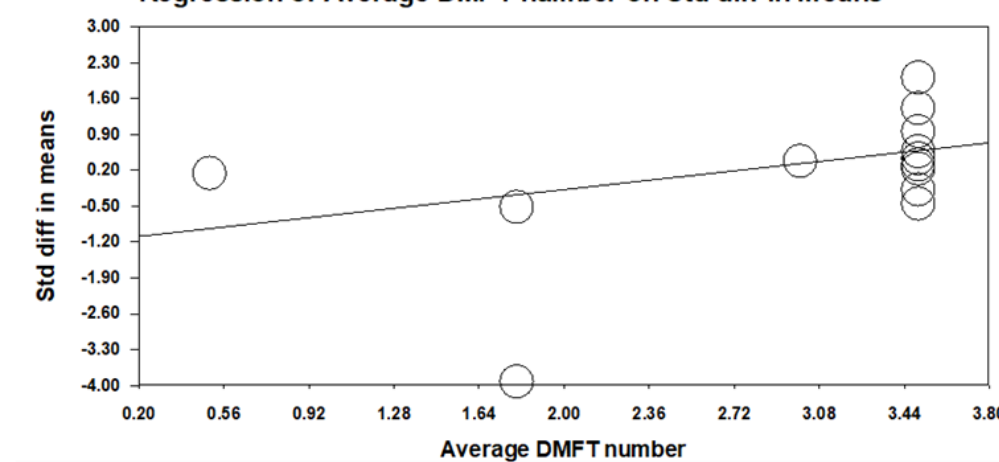
Figure 3. The meta-regression analysis of the average DMFT number in each country during 1994–2014. The standard difference in means of DMFT index in the forest plot was positively correlated with the 12-year-old children average DMFT number of the corresponding country during 1994–2014. B = 0.51, SE = 0.07, 95% CI: 0.37–0.65, p < 0.001.